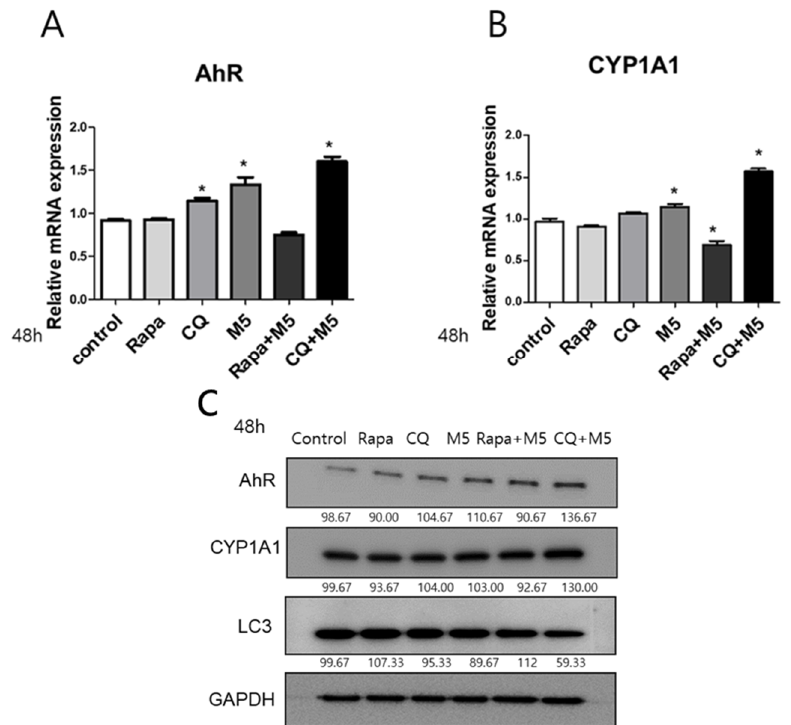
Figure 3. Autophagy inhibition significantly upregulated AhR, CYP1A1 genes, and proteins in M5-stimulated HaCaT cells. The mRNA was harvested from HaCaT cells treated with rapamycin (50 nM), CQ (20 µ g / mL), M5 (10 ng / mL), rapamycin + M5, and CQ + M5 for 48 h. ( A ) AhR mRNA was detected by qPCR and relative expression was normalized to GAPDH. Data are presented as the mean ± S.D. of at least three independent experiments (each performed in duplicate). Statistical significance was determined by one-way ANOVA followed multiple comparison Tukey’s test. * p < 0.05 in comparison to unstimulated cells. ( B ) CYP1A1 mRNA was detected by qPCR and relative expression was normalized to GAPDH. Data are presented as the mean ± S.D. of at least three independent experiments (each performed in duplicate). Statistical significance was determined by one-way ANOVA followed multiple comparison Tukey’s test. * p < 0.05 in comparison to unstimulated cells. ( C ) Western blot analysis of HaCaT cells stimulated with 50 nM rapamycin, 20 µ g / mL CQ, M5 (10 ng / mL), rapamycin + M5, or CQ + M5 for 48 h using antibodies against AhR and CYP1A1, and LC3; relative expression was normalized with GAPDH. The results are representative of three independent experiments. Rapa, rapamycin, CQ, chloroquine, GAPDH, glyceraldehyde 3-phosphate dehydrogenase.